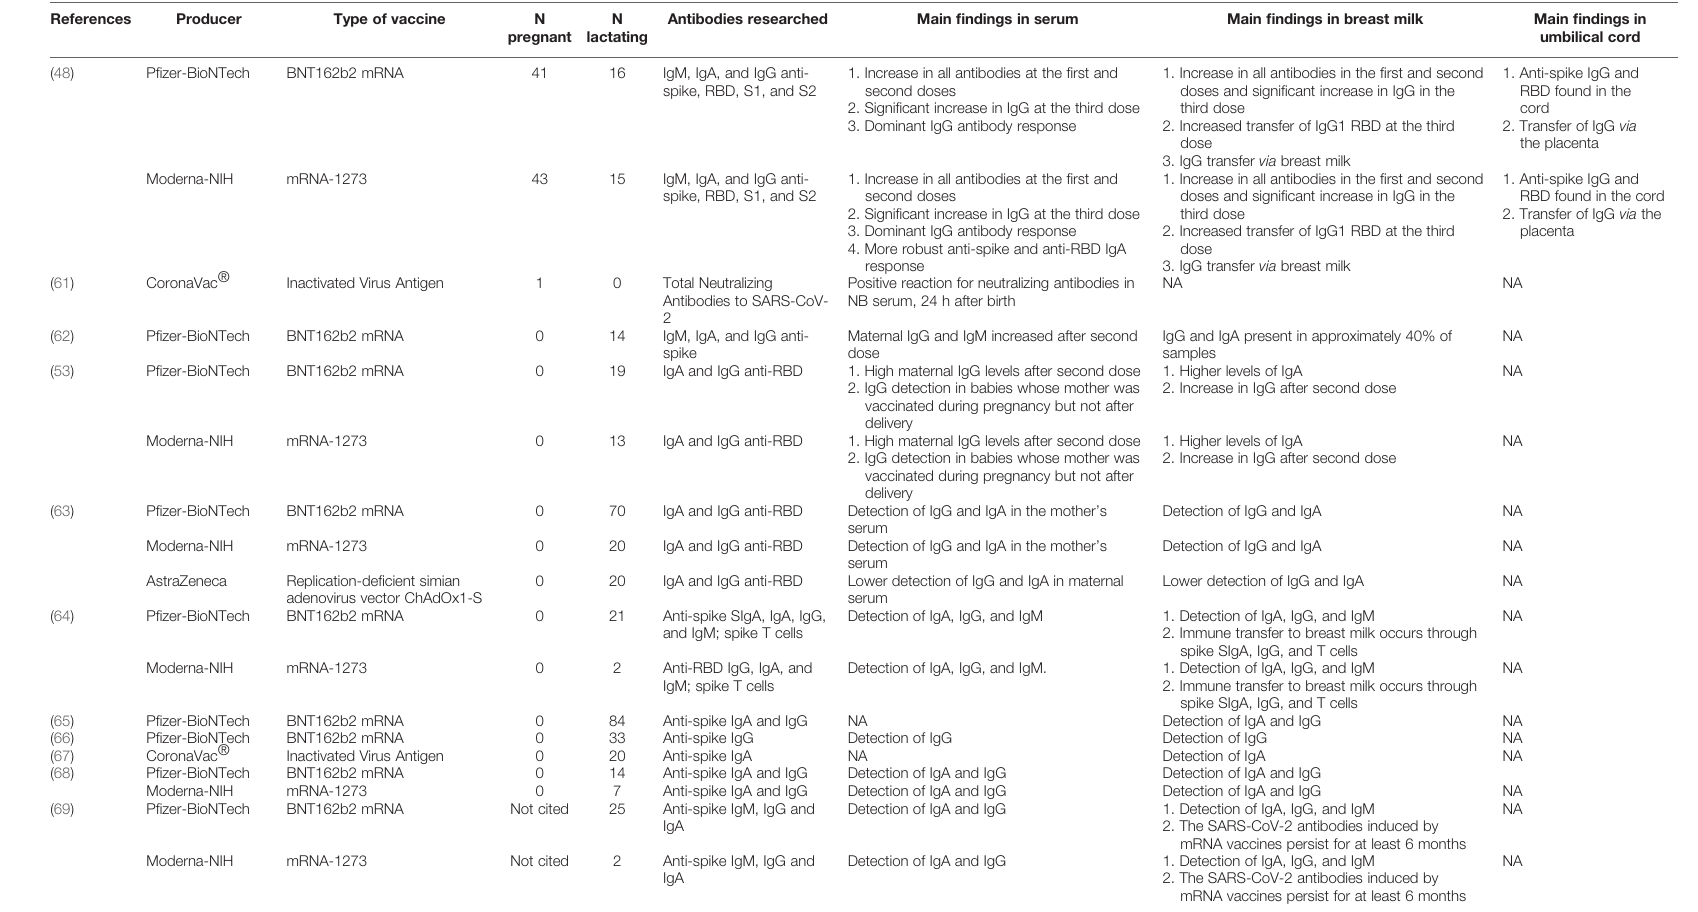
TABLE 1 | Anti-SARS-CoV-2 antibodies production and maternal – fetal transfer after COVID-19 vaccination.